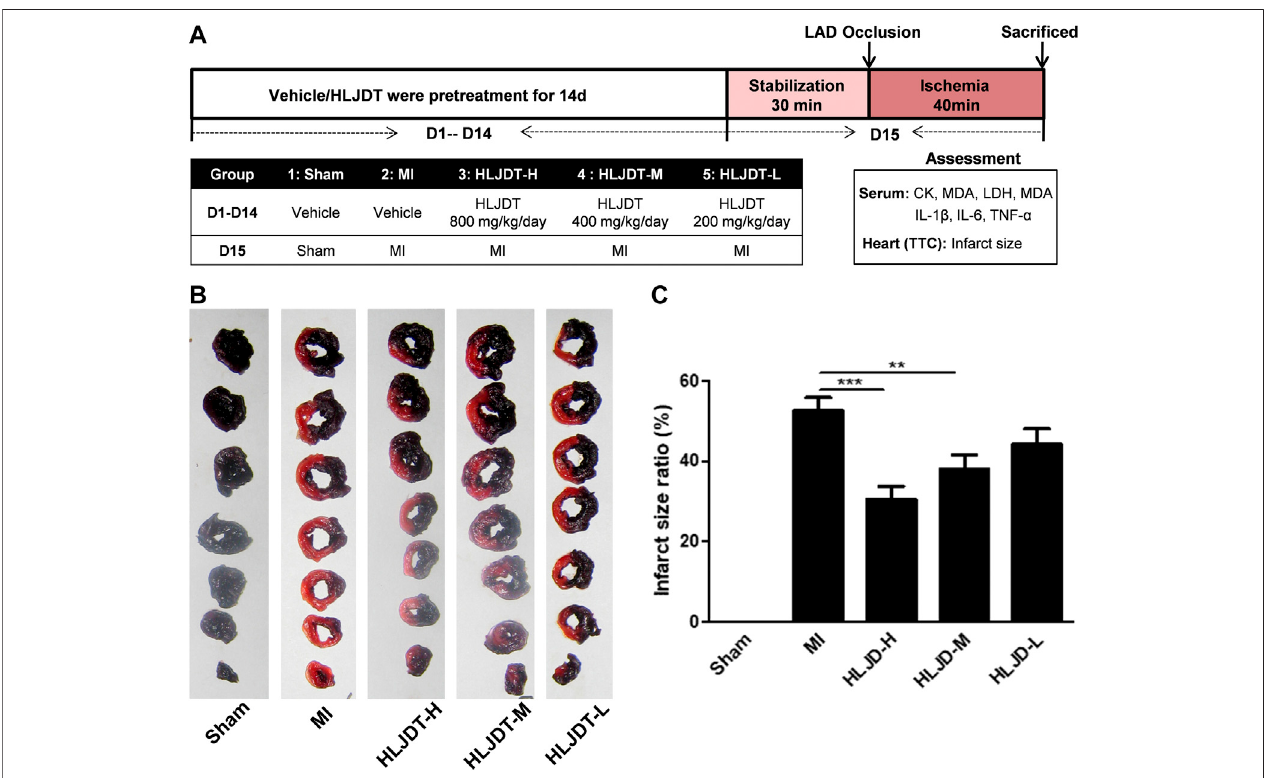
FIGURE 5 | HLJDT reduced infarct size after MI. (A) The experimental procedures of in vivo MI rat model; (B) Representative photographs of TTC stained heart slices obtained after MI; (C) Graphic representation of myocardial infarct size. (B) Bar graphic representation of statistical analysis myocardial infarct size (n < 6). All data expressed as mean ± SEM, n (cid:2) 6/group. **p < 0.01, ***p < 0.001 vs. MI